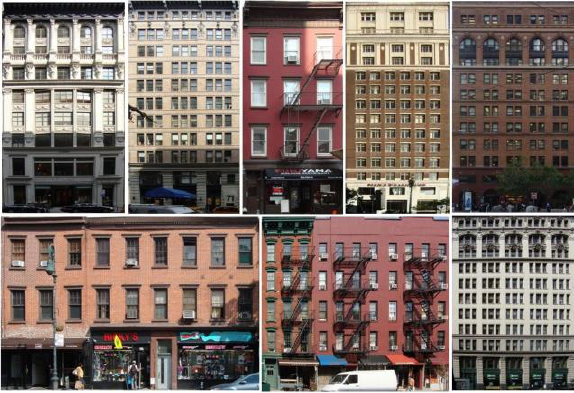
Figure 4. Sample rectified images of building façades from the CMP database. The complete database comprises of 606 labelled images from around the